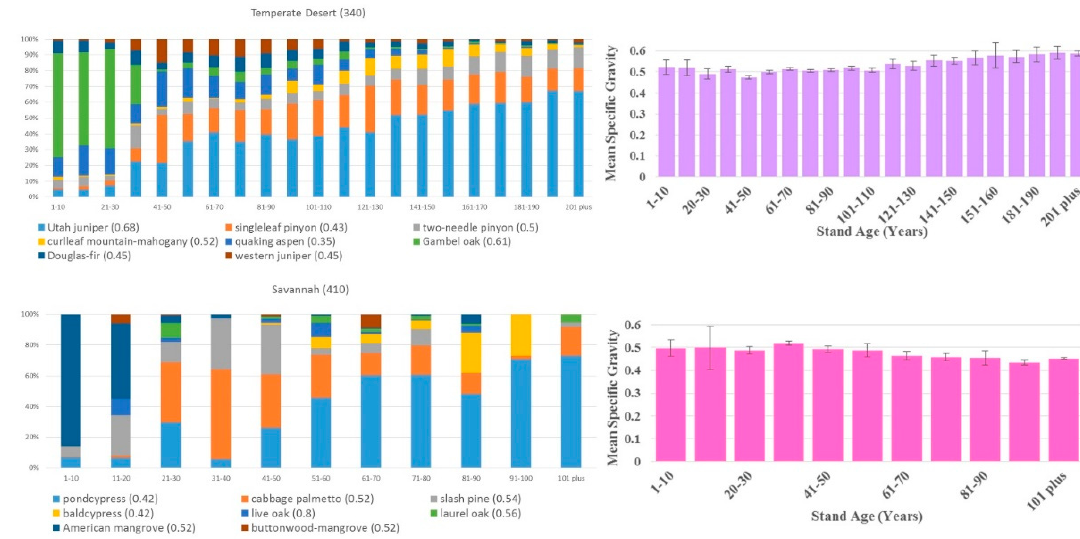
Figure 2. Species distribution by basal area across age groups of the eight most common species in each ecological division ( left ) and the division’s basal area-weighted mean wood specific gravity across age, considering all species ( right ). Error bars represent FIA sampling error. Bar color on the right matches the division’s color on the map in Figure 1.